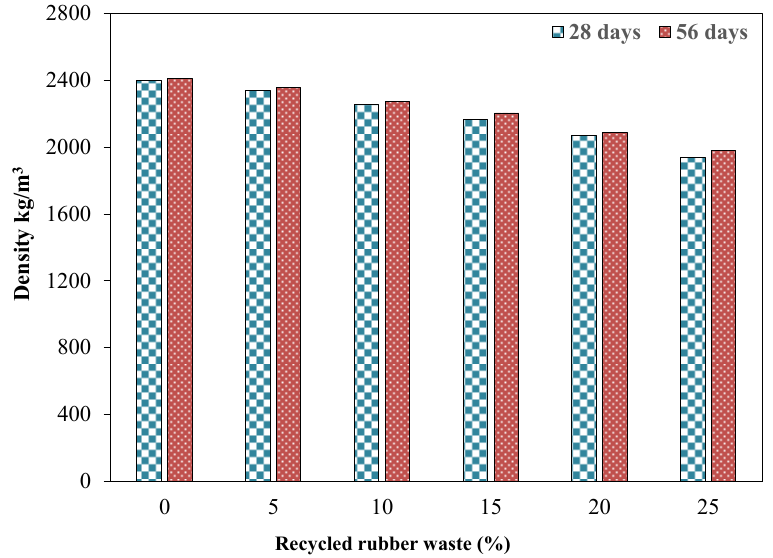
Figure 7. Density of specimens incorporating various dosages of RW at various ages.